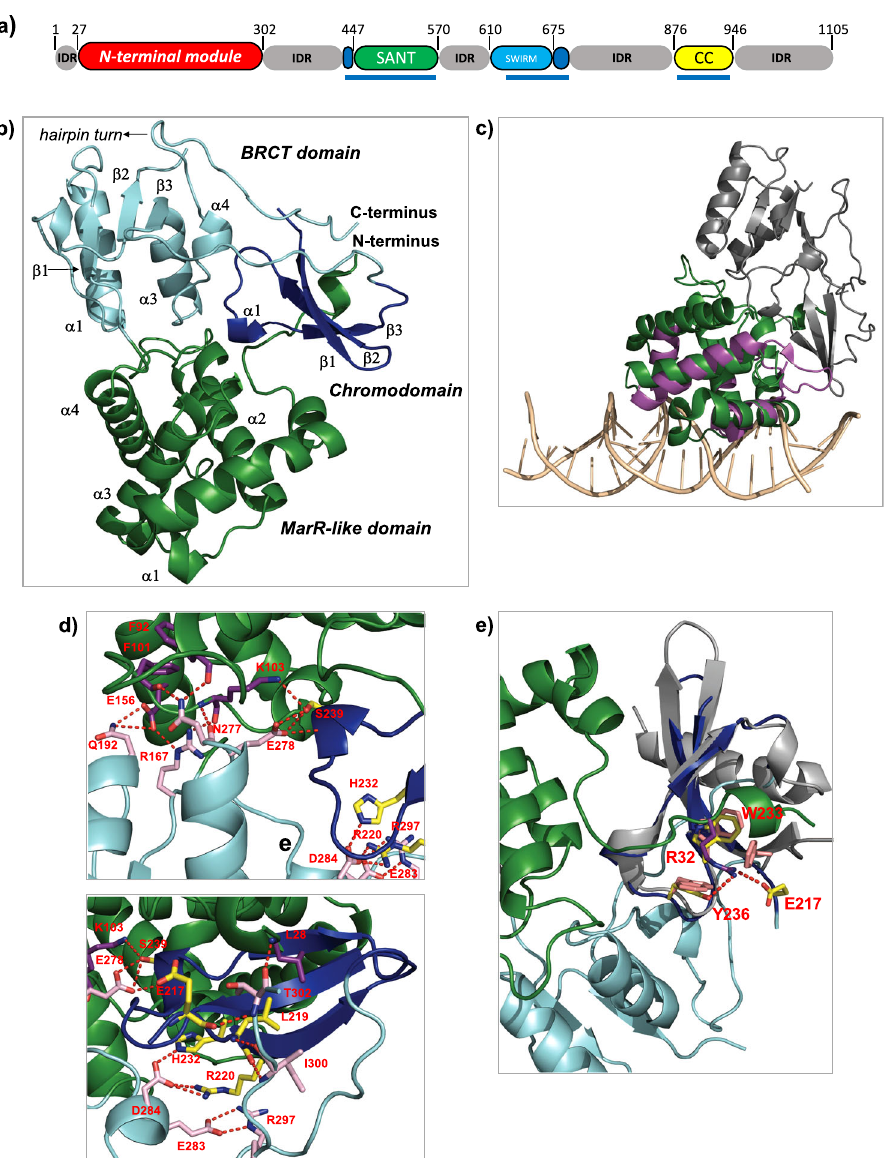
Fig. 1 X-ray structure of the N-terminal module of BAF155. a Domain organization of BAF155. Blue bars indicate regions visible in the cryo-EM structure (6LTH). b Cartoon representation of the structure with BRCT domain in cyan, chromodomain in blue, the MarR-like domain in green. c Overlay of the carton representations of the MarR-like domain structure (in green) of BAF155 and of the protein TipAL (in purple, bound to DNA in orange, PBD ID = 2VZ4). d Zoom in of the hydrogen-bonding network. Residues in the hydrogen-bonding network are shown in stick representation for the three domains and the C- and the N-termini (pink = BRCT domain, yellow = chromodomain, purple = MarR-like domain). e Overlay of the cartoon representation of the chromodomains of BAF155 (in blue) and CBX7 (PDB ID = 4X3K) (in grey). Residues of the aromatic cage are shown in yellow in BAF155 and in pink in CBX7, illustrating the blocking of the methyl-lysine-binding site on BAF155 by Arg32 (in